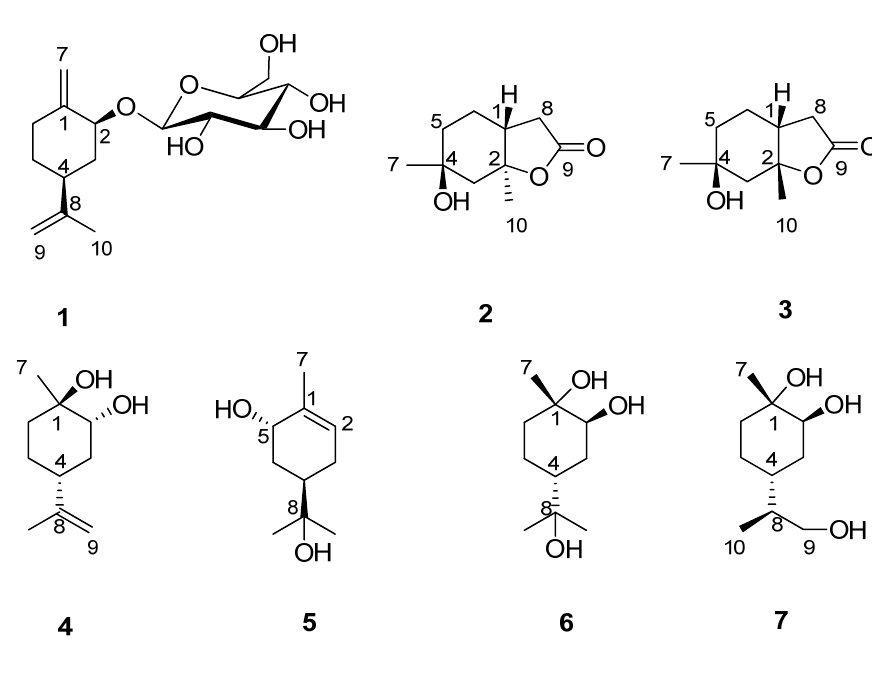
Figure 1. Structures of compounds 1 – 7